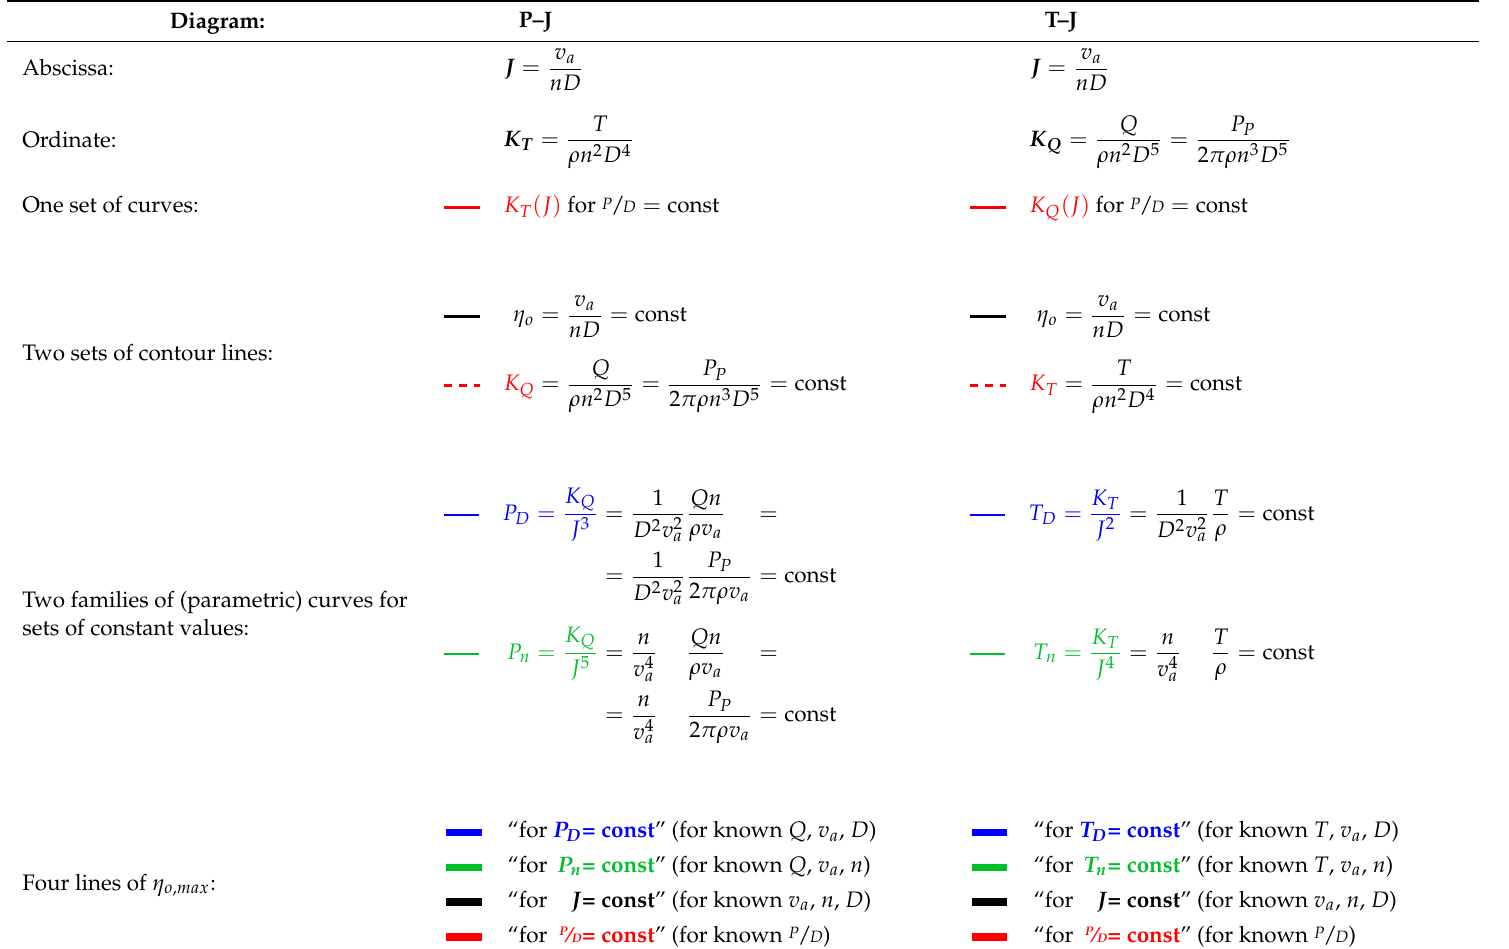
Table A4. Composition of the Danckwardt P–J ( K T – J ) and T–J ( K Q – J ) efficiency maps. Additionally shown is the significations of line colour and type. K T = thrust coefficient; K Q = torque coefficient; η o = open-water efficiency; J = advance coefficient; T = thrust; Q = torque; P P = propeller power; D = propeller diameter; P = propeller pitch; n = shaft speed (in s −1 ); v a = speed of advance; and ρ = water density. If not stated otherwise, all values are in SI base